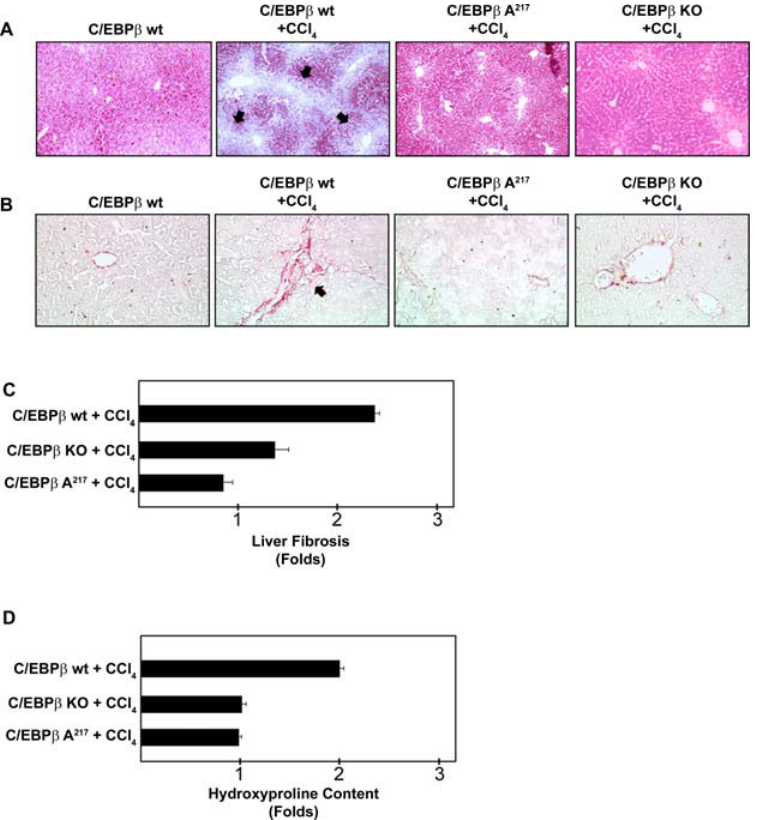
Figure 1. Mice expressing the RSK-inhibitory C/EBP b -Ala217 transgene are refractory to the induction of liver fibrosis. C/EBP b + / + [wt], C/EBP b - Ala217 and C/EBP b 2 / 2 [ko] mice received weekly IP injections of CCl 4 or mineral oil (control) for 12 weeks as described in Methods. A. Representative Mallory’s trichrome stain for liver fibrosis (in blue; arrowheads). All C/EBP b + / + (wt) mice ( n : 12) developed severe liver fibrosis. The C/EBP b -Ala217 ( n : 12; P , 0.0001 ) and C/EBP b 2 / 2 [ko] ( n : 6; P , 0.01 ) mice had either no fibrosis or only minimal liver fibrosis. B. Representative Sirius red immunohistochemistry for collagen (in red; arrowhead). Marked increase in liver collagen in a cirrhotic pattern was observed in C/EBP b + / + , but not in C/EBP b -Ala 217 or C/EBP b 2 / 2 [ko], mice. C. Analysis of hepatic collagen content by the Sirius red collagen–binding assay, showed a , 2.5-fold increase in C/EBP b + / + mice treated with CCl 4 ( n : 12), compared to C/EBP b -Ala217 mice treated with CCl 4 ( n : 12; P , 0.001 ). C/EBP b 2 / 2 mice were also refractory to the induction of liver fibrosis by CCl 4 ( n : 6; P , 0.01 ). D. Analysis of hepatic collagen content by the hydroxyproline assay, showed a , 2- fold increase in C/EBP b + / + mice treated with CCl 4 ( n : 7), compared to C/EBP b -Ala217 mice treated with CCl 4 ( n : 6; P , 0.01 ). C/EBP b 2 / 2 mice were also refractory to the induction of liver fibrosis by CCl 4 ( n : 6; P , 0.01